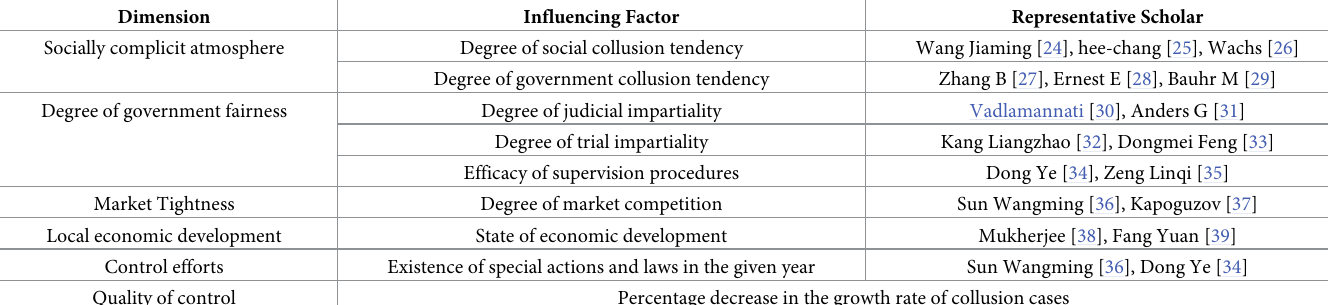
Table 2. Key influencing factors for vertical collusion in